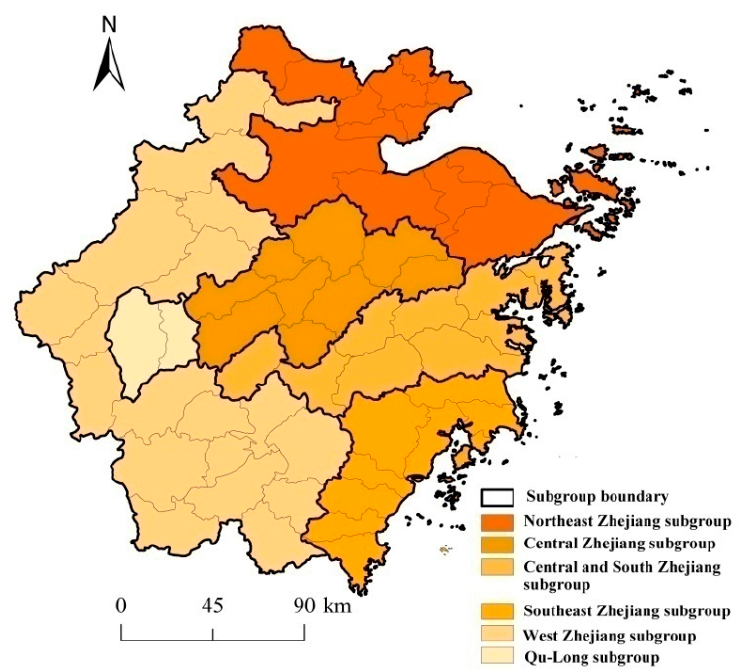
Figure 5. Cohesive network subgroups at the county level in Zhejiang Province.